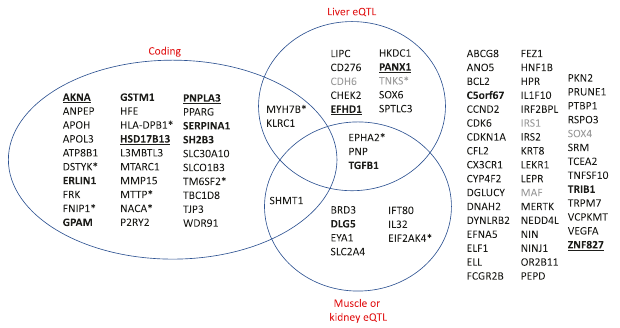
Fig. 2 Classi fi cation of the top ALT- and AST- associated loci based on annotations. Unless otherwise noted with an asterisk, loci are named by the closest protein-coding gene. “ Coding ” indicates that one of the variants linked to the lead variant is predicted to have a moderate or high impact on a protein-coding gene. “ Liver eQTL ” and “ Muscle or kidney eQTL ” indicate that one of the variants linked to the lead variant is the strongest eQTL for a gene in those tissues by GTEx. Loci are further categorized as followed: asterisk, indicating the locus is named for a gene other than the closest to the lead variant, due to coding or eQTL annotation; gray, indicating the lead variant is over 100 kilobases from a protein-coding gene; bold, indicating a known GWAS catalog ALT or AST locus; bold and underlined, indicating a known GWAS catalog ALT and AST locus. Source data for this fi gure are in Supplementary Data